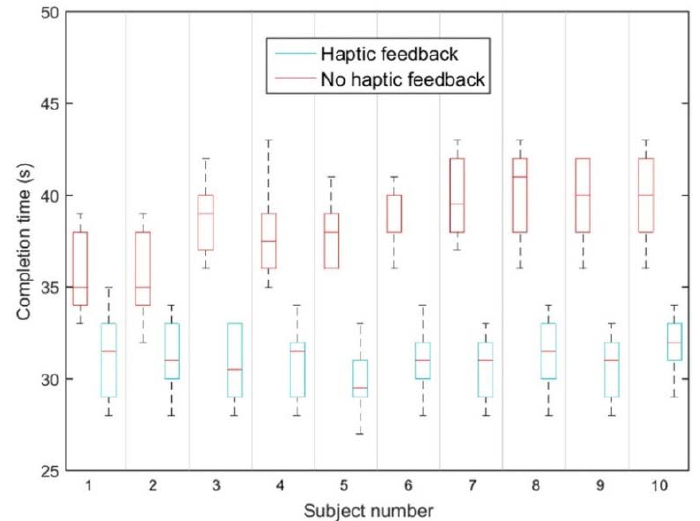
Figure 18. Mean values of task-completion time for each.